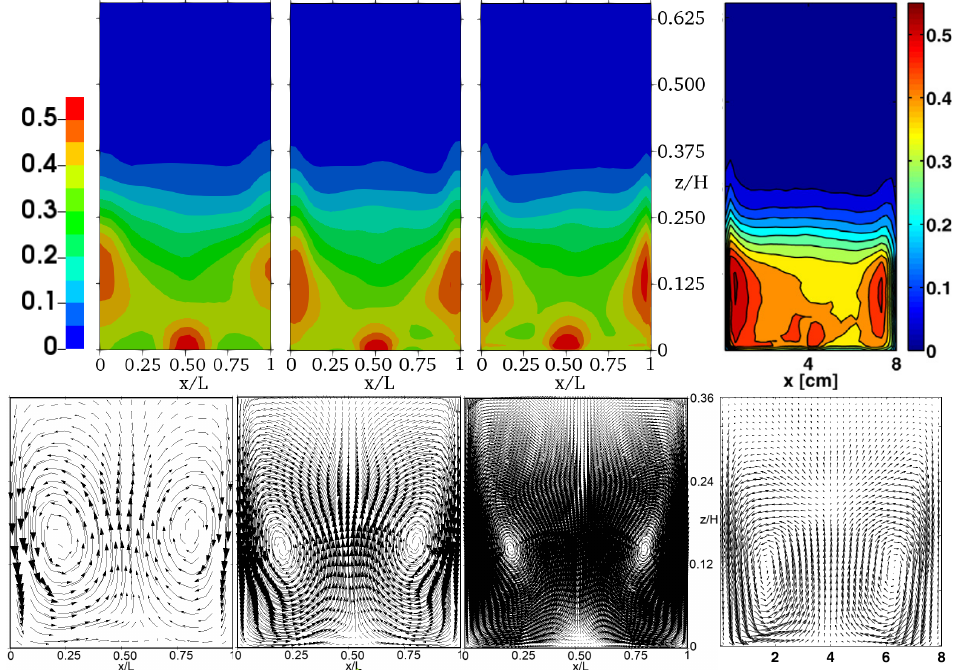
Figure 12. Numerical predictions of the time-averaged fields of the volume fraction, < α p > xz , (upper panel) and the mass flux, < α p ρ p U p > xz , (bottom panel) of the solid phase. From left to right, increasing grid refinement with µ w = µ p = 0.2, and comparison with the experiments (right column). Re p = 70 and bed weight 75